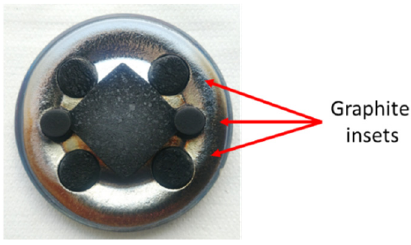
Figure 11. The image of Ti sputtering target with graphite insets.